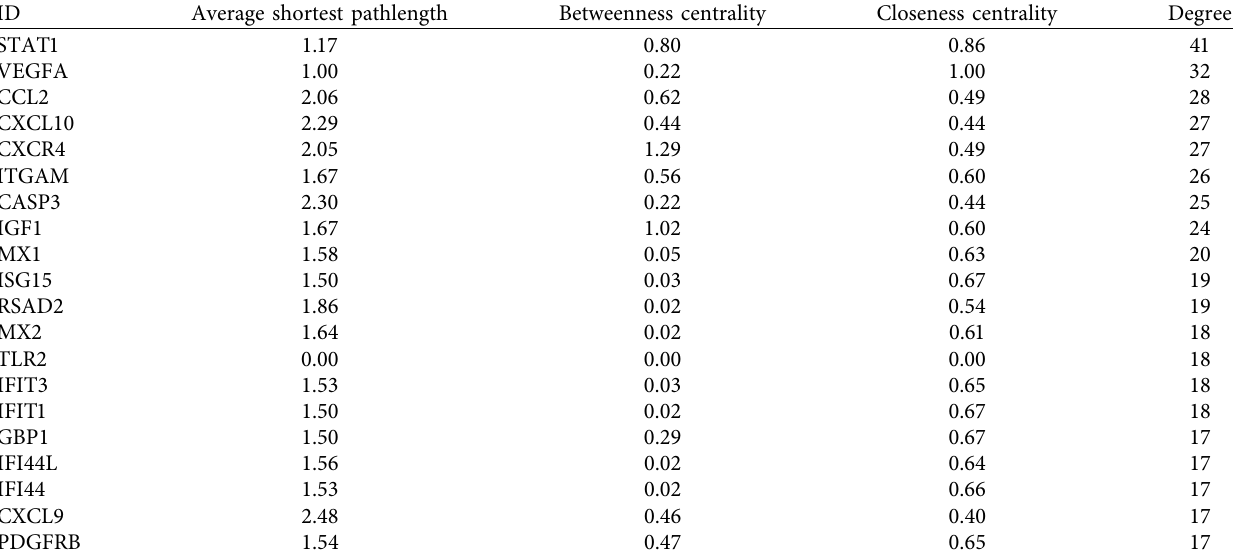
Table 1: Te centrality parameters of the top20 genes in the protein-protein interaction